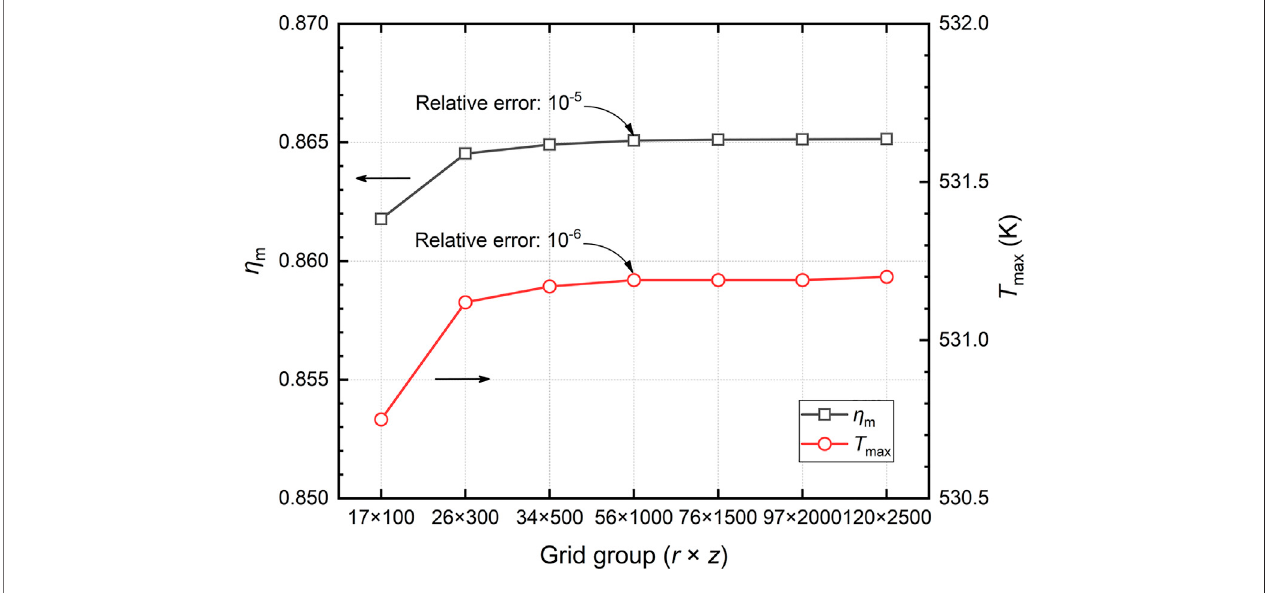
FIGURE 3 | Grid independence veri fi cation.